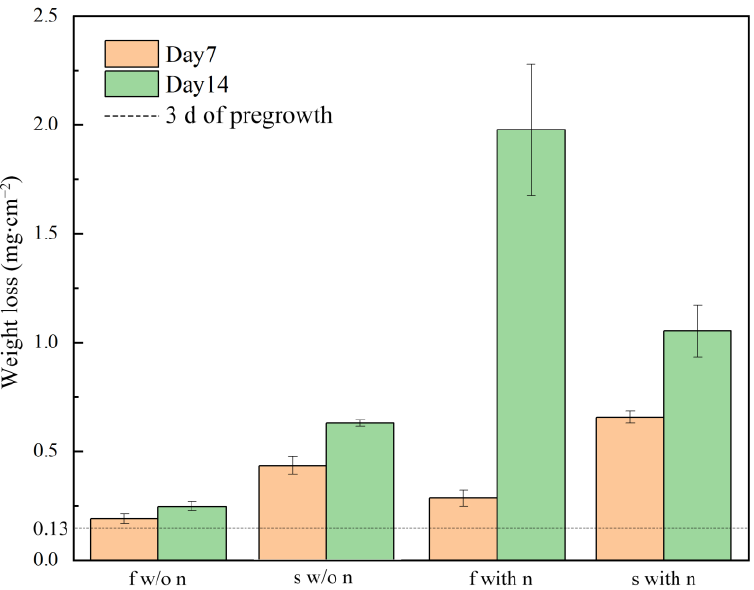
Figure 3. Corrosion weight loss of EH40 steel after 7 and 14 days of immersion in different systems (f w/o n: full system without nitrate addition, s w/o n: starvation system without nitrate addition, f with n: full system with nitrate addition, and s with n: starvation system with nitrate addition).